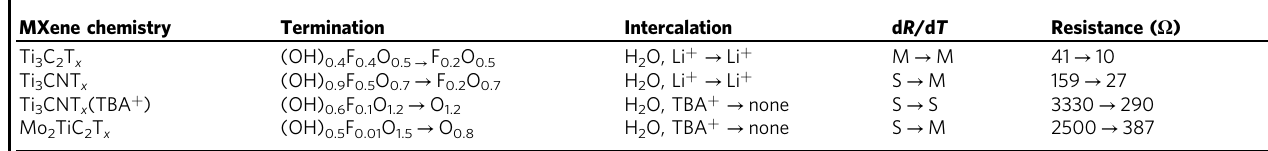
Table 1 Summary of in situ heating and biasing